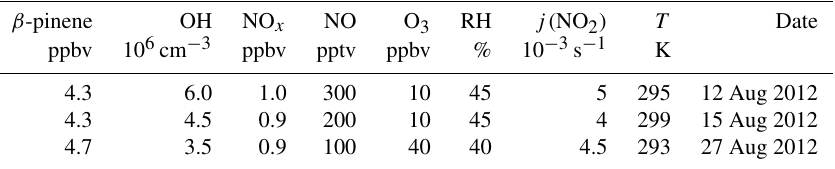
Table 2. Experimental conditions of the β -pinene oxidation experiments. Maximum values are given for β -pinene and averaged values for the part of the experiment, when β -pinene was present, for the other parameters. β -pinene OH NO x NO O 3